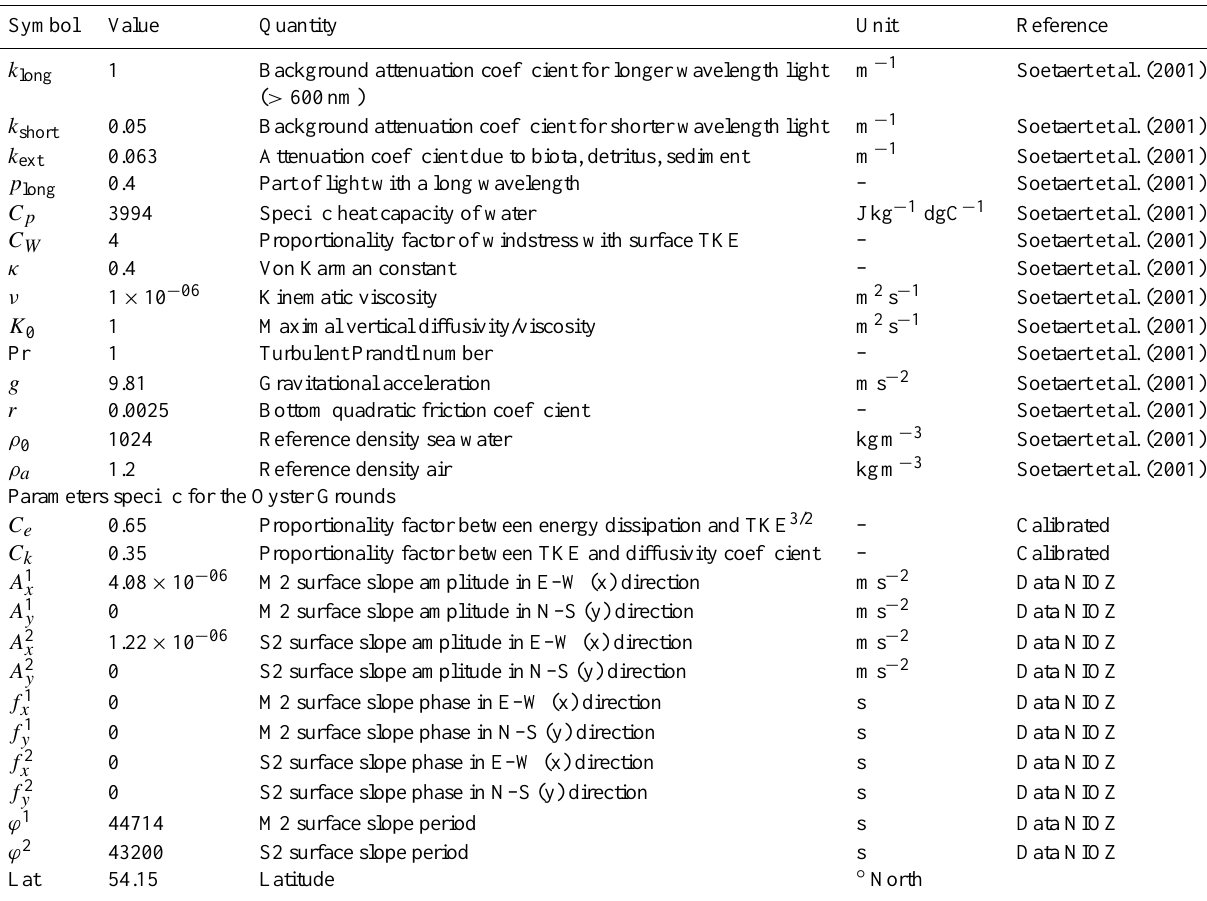
Table 3. Parameter values of the physical k - ε model.